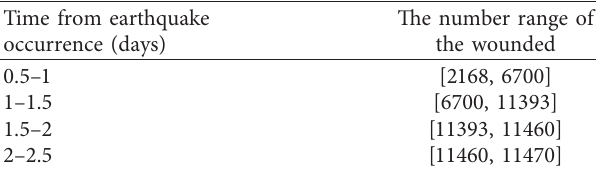
Table 2: The number range of the wounded after the